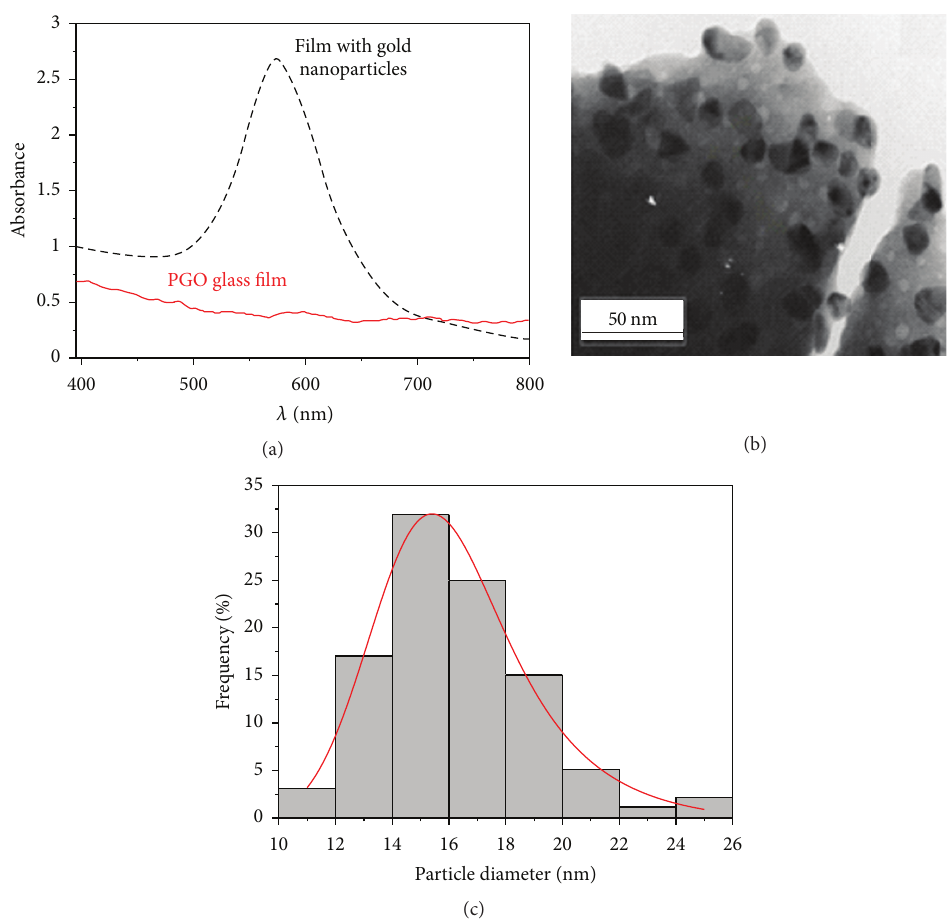
Figure 22: (a) Absorbance spectra of the PGO film with and without gold NPs at room temperature (films thickness: 1.1 𝜇 m). (b) TEM image of the PGO:Au film. (c) Size distribution histogram of the gold NPs [5].